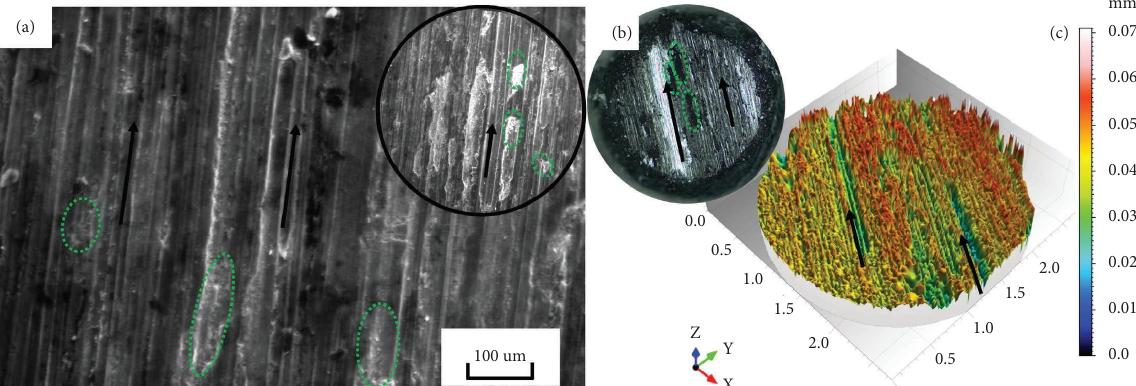
Figure 12: SEM image, optical microscopy, and 3D surface topographies of the wear track of the Al ball.